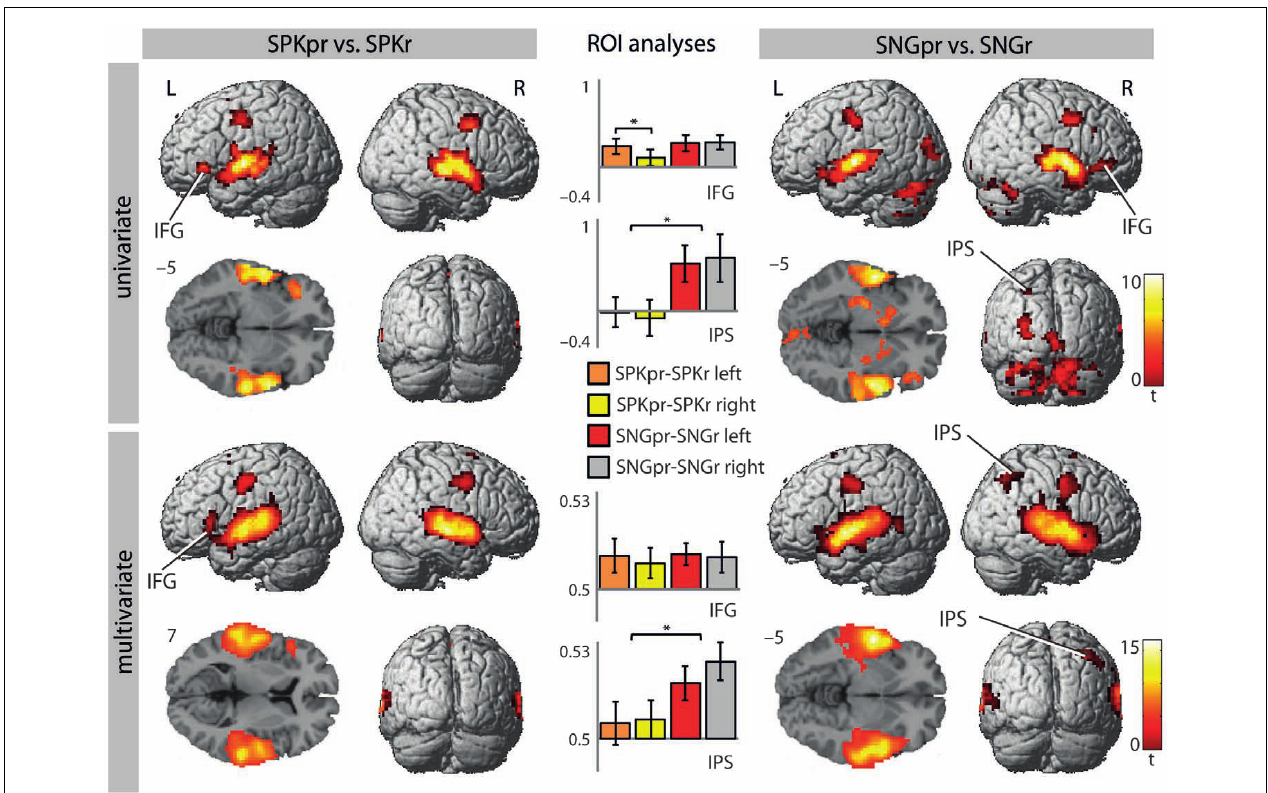
(UVA) and accuracy values (MVPA) of the shown contrasts extracted from left and right BA 47 and the IPS. Significant results of the ROI analysis are indicated by an asterisk (* p < 0.05). Colour scales on the right indicate t -values for each row. IFG, inferior frontal gyrus; IPS, intraparietal sulcus.